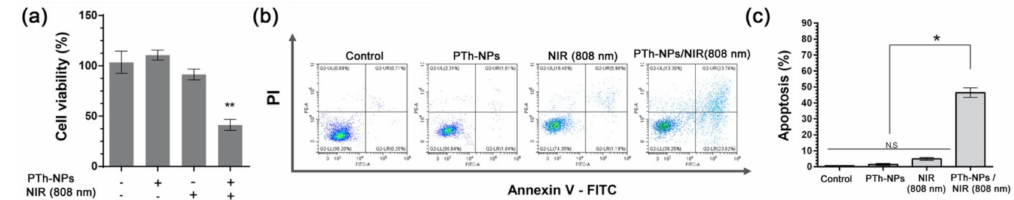
Figure 6. Photothermal e ff ects of PTh–NPs on apoptotic cell death. ( a ) Cell viability of PTh–NPs (100 µ g / mL) treated CT-26 cells with / without 808 nm laser irradiation (2.0 W / cm 2 , 5 min) at 24 h of cultivation. ( b ) Flow cytometric analysis to determine cell death of CT-26 cells after PTh–NPs with / without NIR irradiation. ( c ) Percentage of apoptotic CT-26 cells. Each value is expressed as the mean ± standard deviation. * P < 0.05 and ** P < 0.01, when compared to the